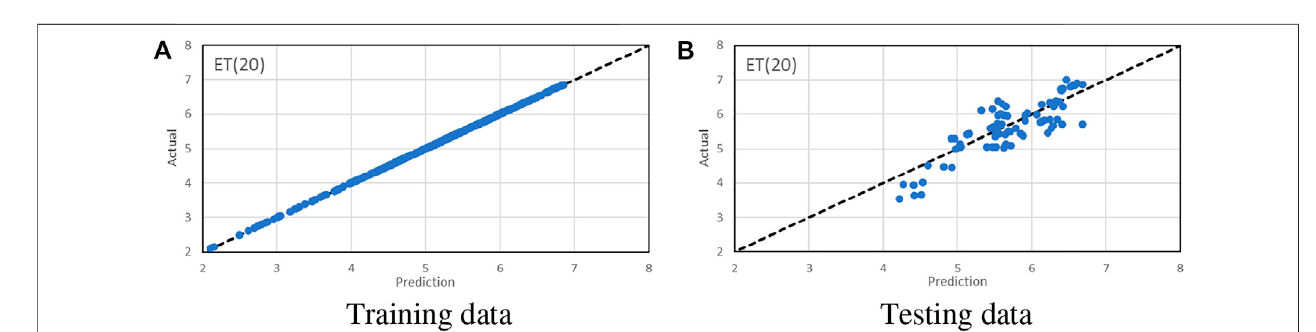
FIGURE 9 | Actual vs. prediction of ET (20)